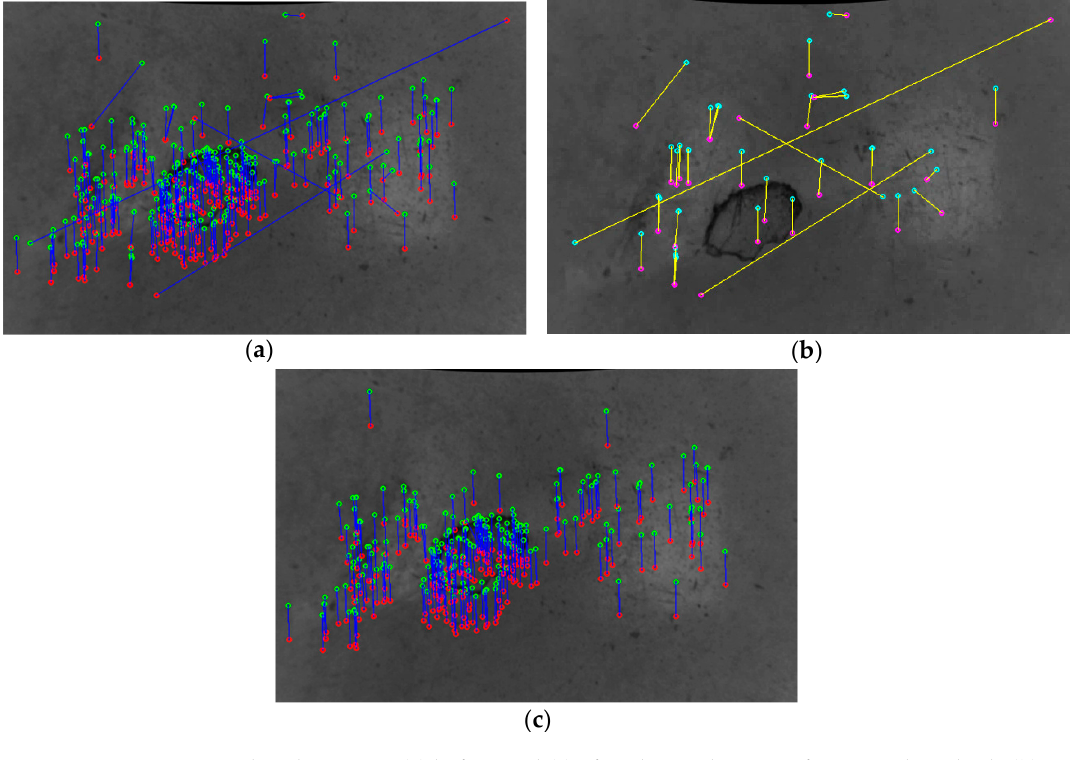
Figure 6. Corresponding keypoints ( a ) before and ( c ) after the application of statistical method. ( b ) Corresponding matchings being filtered out from the following processing.